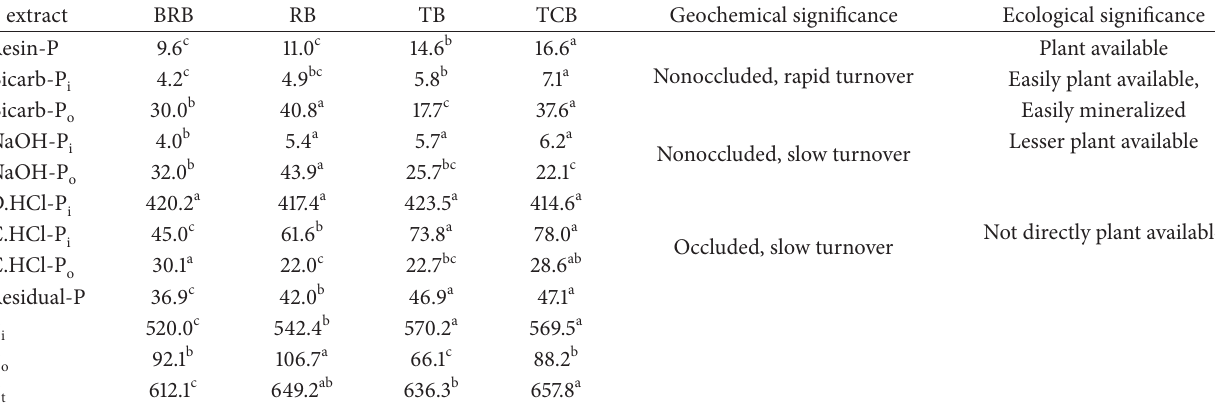
Table 2: Mean soil phosphorus concentrations by fraction in tidal river network region soils listed as mg Pkg − 1 soil. Means were averaged from 18 soil samples in each type. Duncan multiple-range test was conducted with 17 degrees of freedom. The signification of different forms of phosphorus was described in